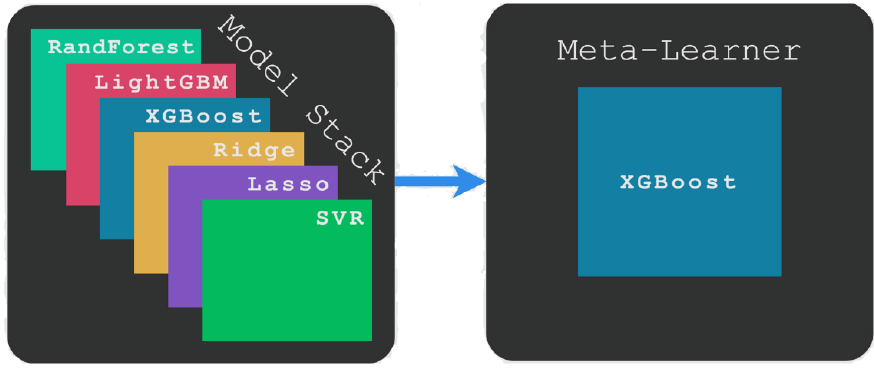
Figure 9. Stacking process implemented [36].